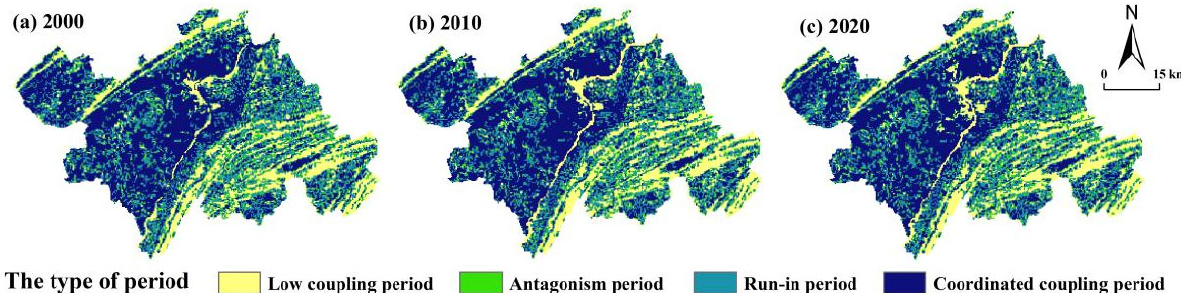
Figure 4. Coupling degree of the PLEFs in 2000(a), 2010(b), and 2020(c)